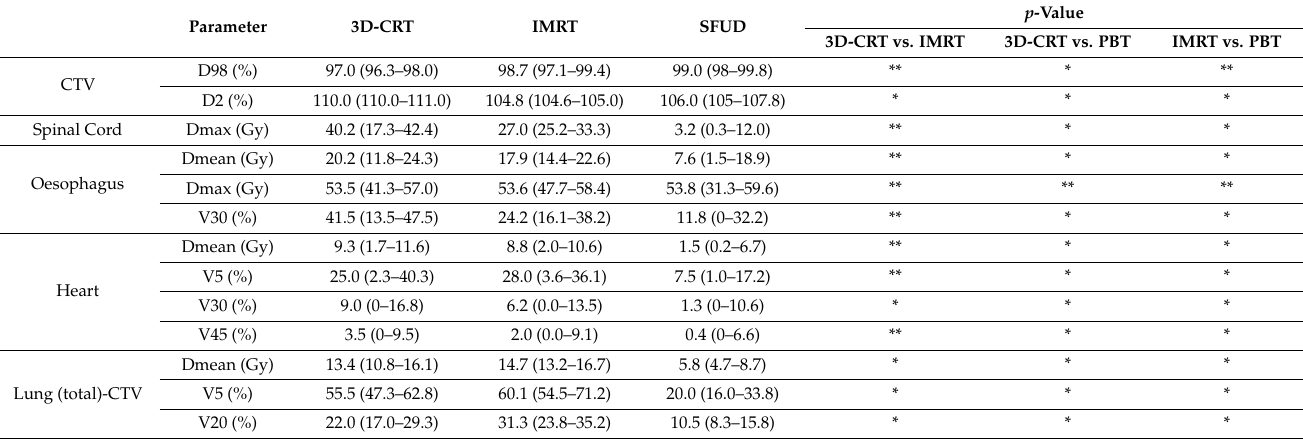
Table 2. Dosimetric comparison between 3D-CRT, IMRT and PBT plans. Median values and the values of the first and third quartile are also